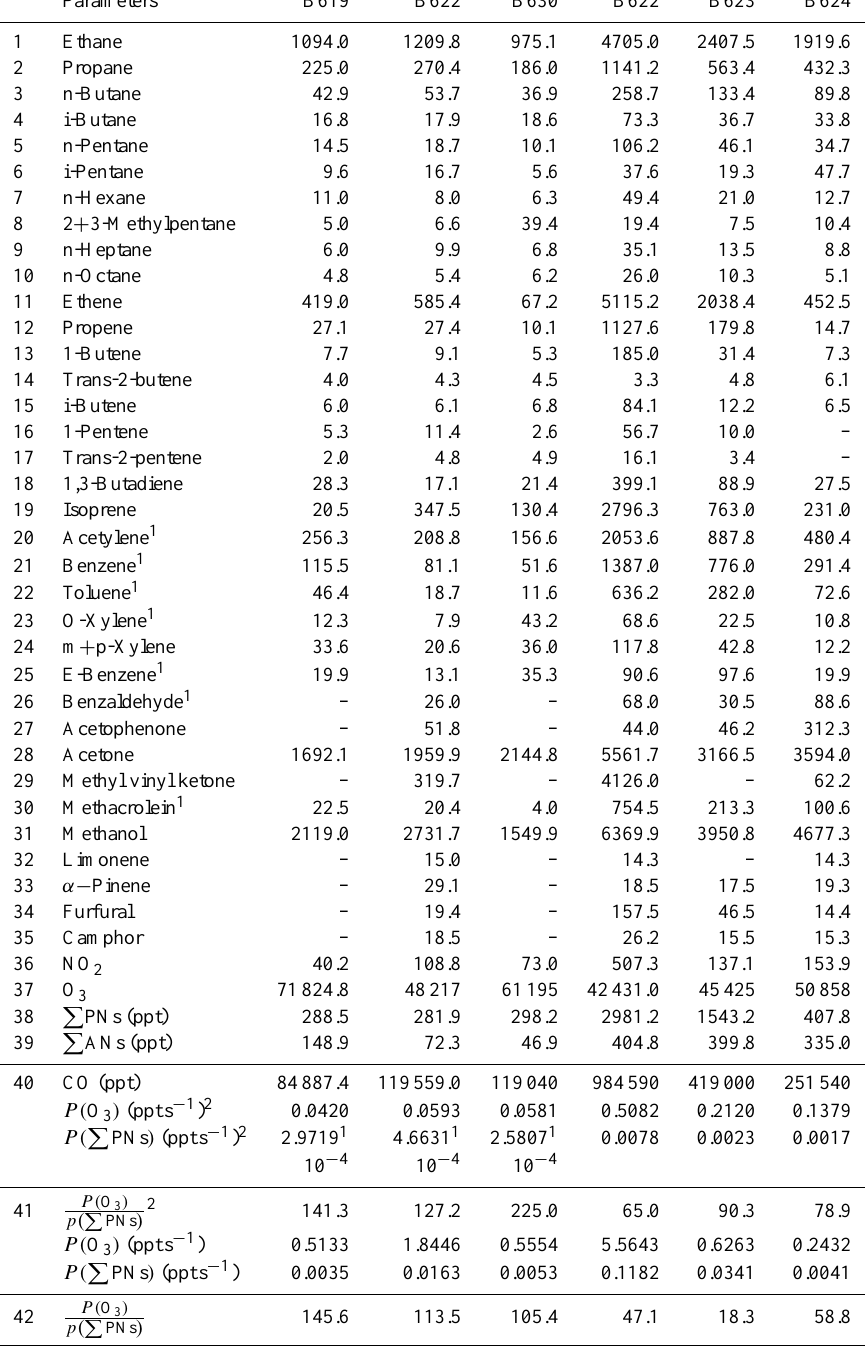
Table 2. Concentrations of each species involved in the P PN and O 3 production (all reported in ppt), the production terms P( O 3 ) and P( P PNs ) (expressed in ppts − 1 ), and their ratios P( O 3 )/P( P PNs ) for all the flights analysed. All the species reported in this table are used for the MCM model calculation of P( O 3 ) and P( P PNs ) . The selected flights are distinguished between the flights where we sampled boreal fire emissions (part of B622, B623 and B624 – labelled “plume” flights) and those in which we measured background air (B619, part of B622 and B630 – labelled “background”